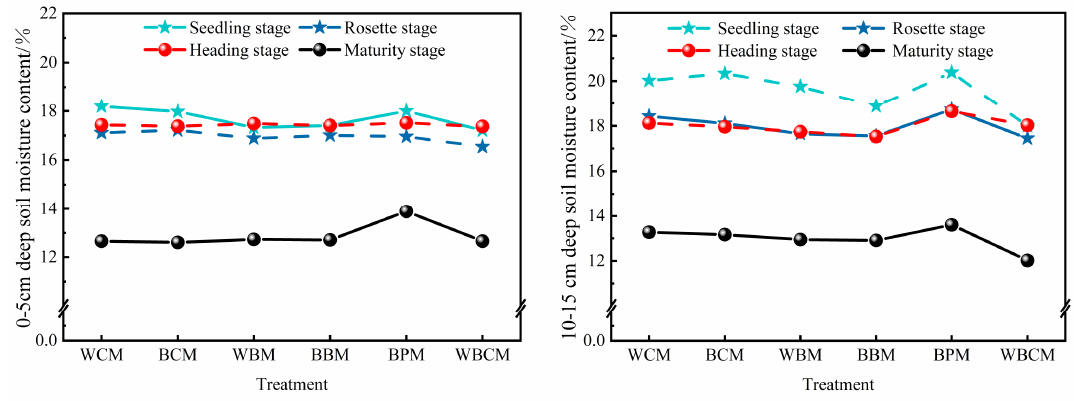
Figure 4. Effects of different treatments on soil water content.